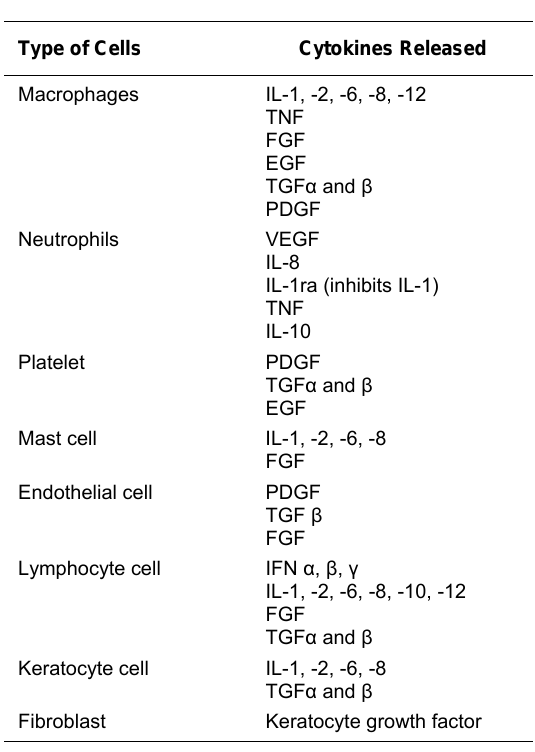
Type of Cytokines Secreted by Various